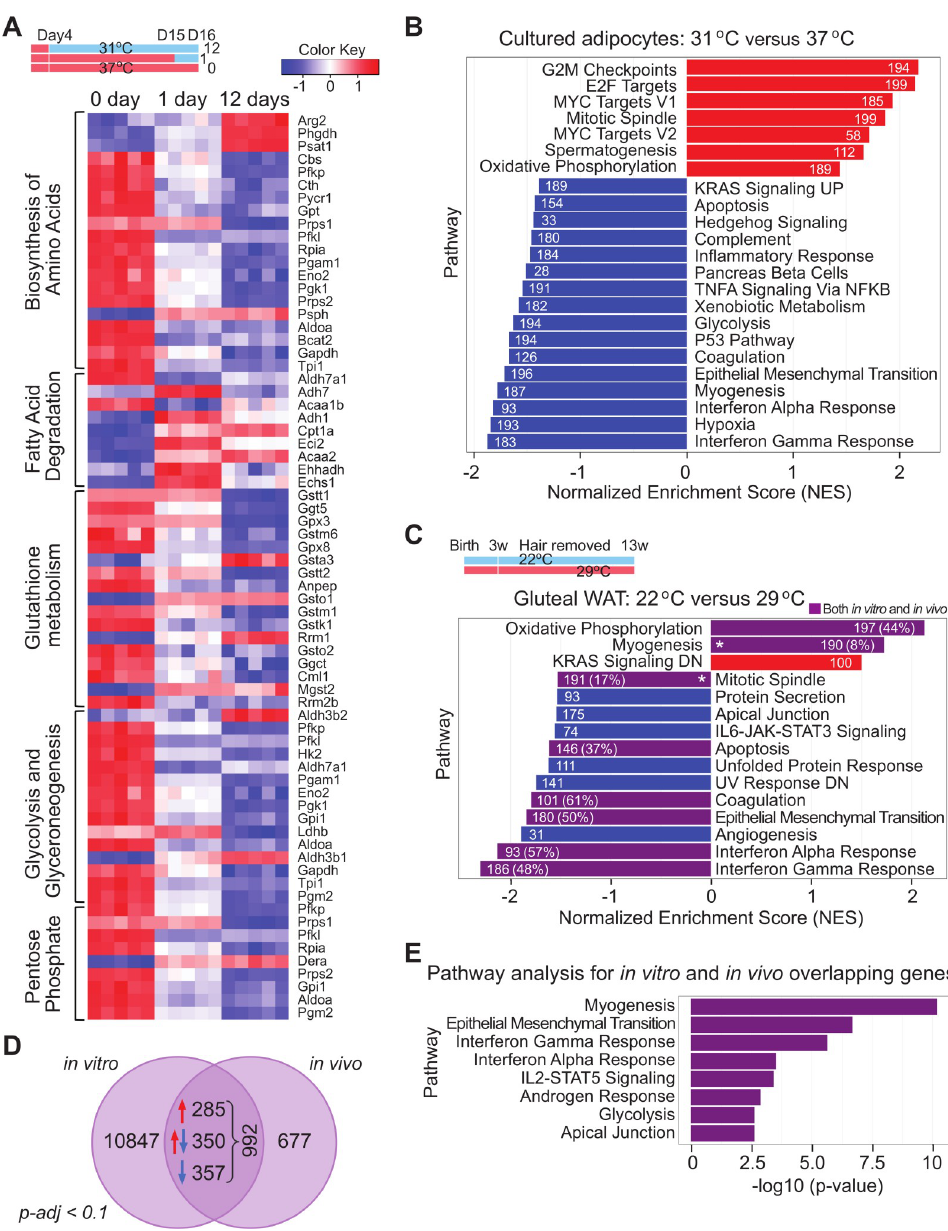
Fig 3. Exposure of adipocytes to 31˚C activates an extensive transcriptomic program of adaptation. ( A, B ) RNA from mature adipocytes at day 0, 1, and 12 of cool adaptation was purified and subjected to RNA-seq analyses ( n = 5 per time point) ( A ). Heat map of select metabolic KEGG pathways significantly enriched by 1 or 12 days of cool temperature from iPathwayGuide pathway impact analysis. Enrichment was defined by a nominal p -value < 0.05 and FDR < 0.25. ( B, C ) Normalized score plots of enriched pathways from preranked GSEA comparing RNA expression in mature adipocytes exposed to 31˚C vs. 37˚C for 12 days ( B ), or in gluteal WAT of mice housed at 22˚C vs. 29˚C for 13 weeks, as described in Fig 1C ( n = 6, 7) ( C) . Enriched pathways were defined by a nominal p -value < 0.05 and FDR < 0.05. p - Values were calculated from GSEA with 1,000 permutations. Numbers in the bars indicate gene set size. Purple bars indicate gene sets shared between datasets, and % indicates proportion of shared leading edge genes with the in vitro data. � indicate common pathways between the in vitro and in vivo data that are regulated in opposing directions. Data shown are from one experiment. ( D ) Venn diagram indicating the numbers of genes similarly regulated (P-adj < 0.1) in cultured adipocytes and gluteal WAT by cool temperatures. ( E ) Pathways identified by Enrichr software from genes regulated in both datasets. Numerical data for all graphs are provided in S3 Data. FDR, false discovery rate; GSEA, gene set enrichment analysis; RNA-seq, RNA sequencing; WAT, white adipose tissue.